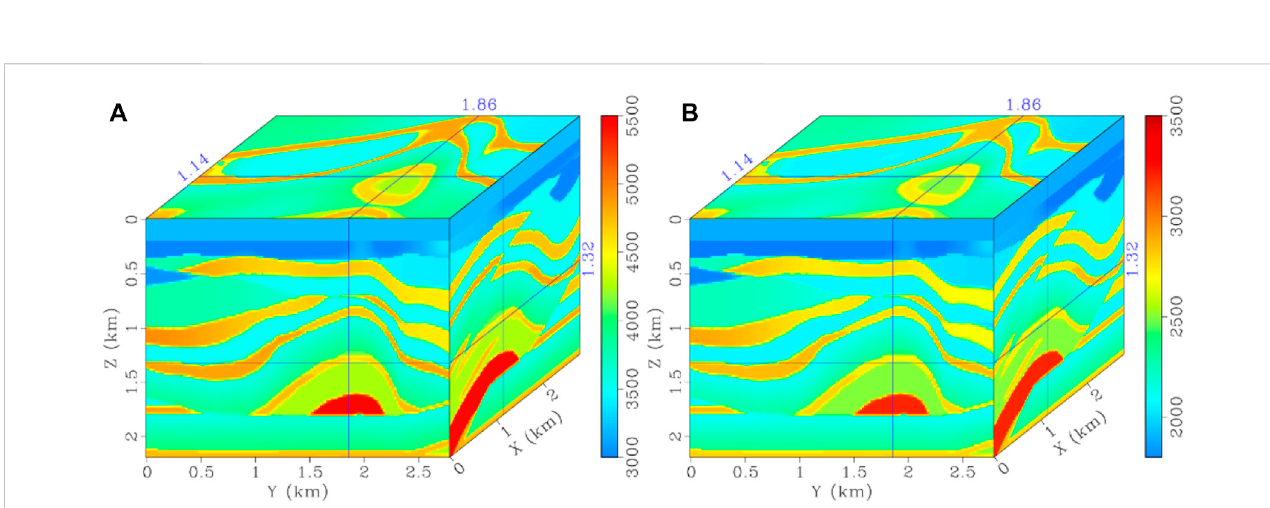
Frontiers in Earth